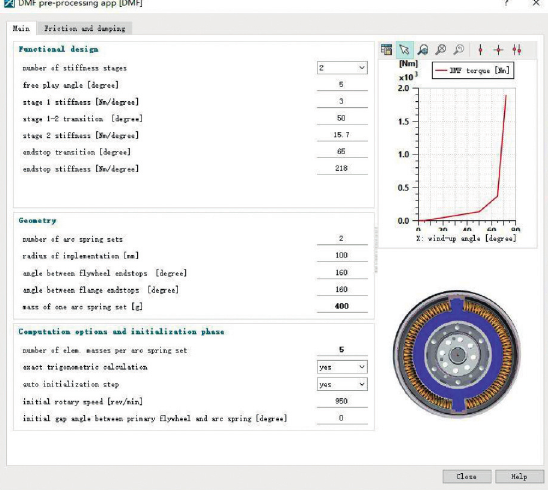
Figure 8: Parameter assignment and commissioning interface of the DMF